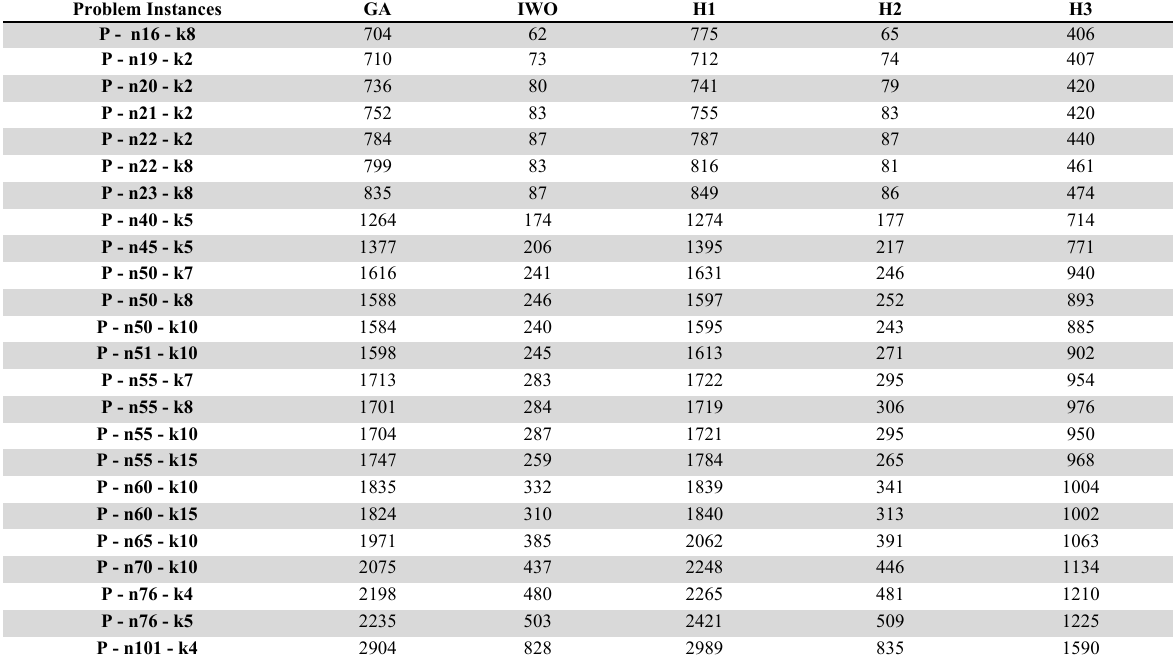
Table 2 CPU time (msec) comparisons of the algorithms for P group test instances Problem Instances